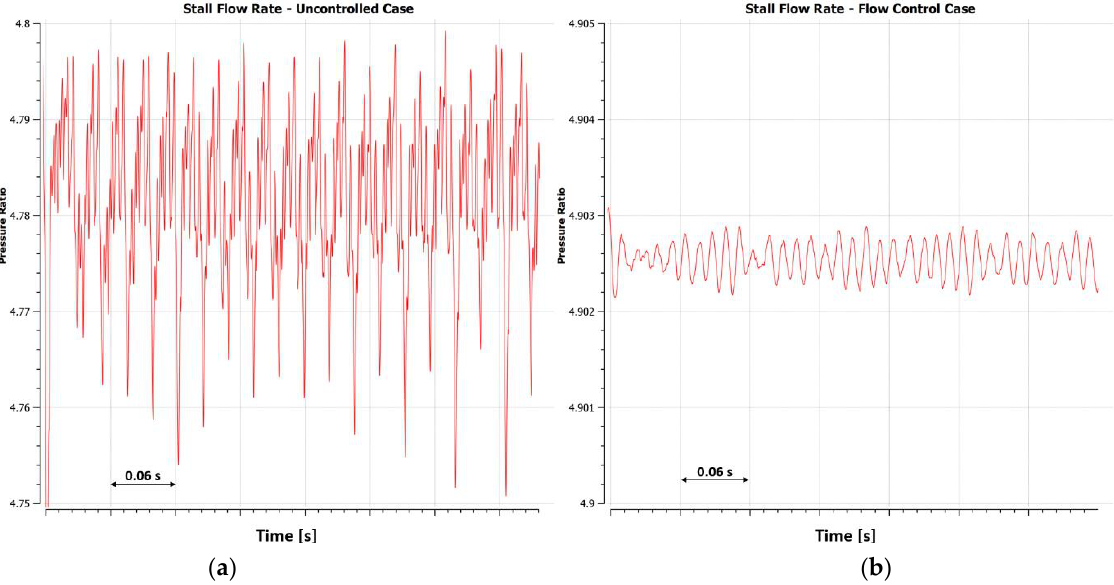
Figure 11. Pressure ratio signals from uncontrolled and controlled cases working at stall flow rate: ( a ) uncontrolled case; ( b ) controlled case.